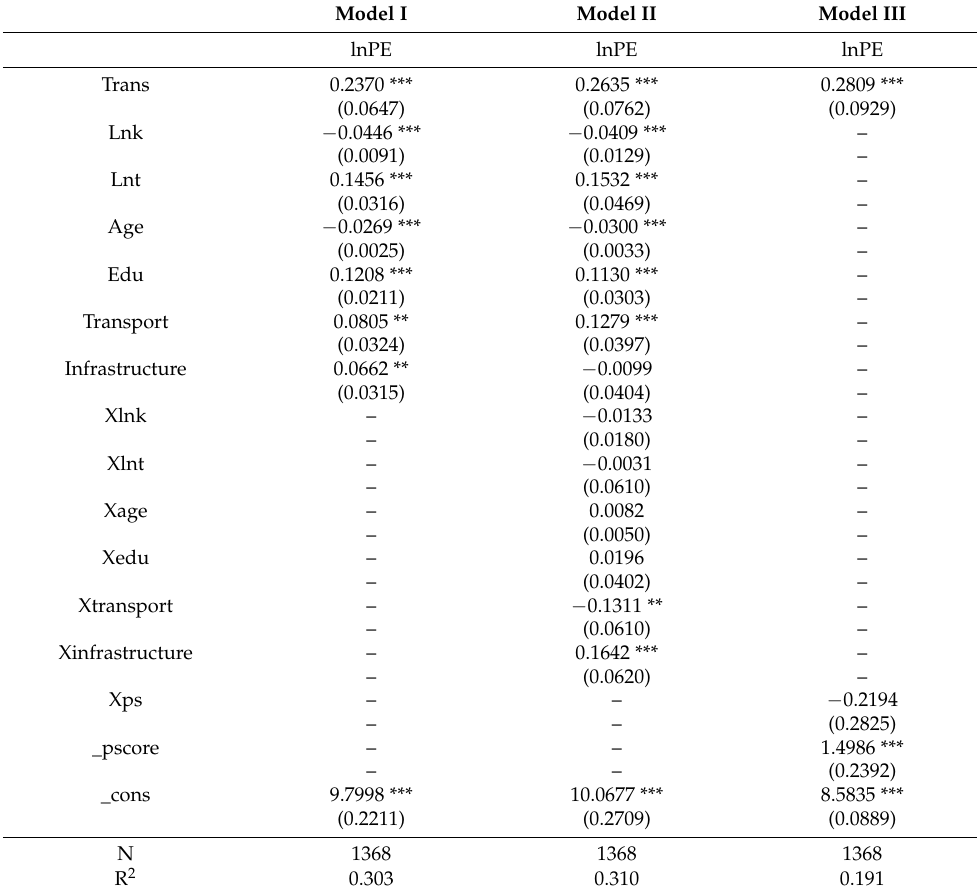
Table 5. Estimation Results of the Average Effect on the Total Productivity of the Whole